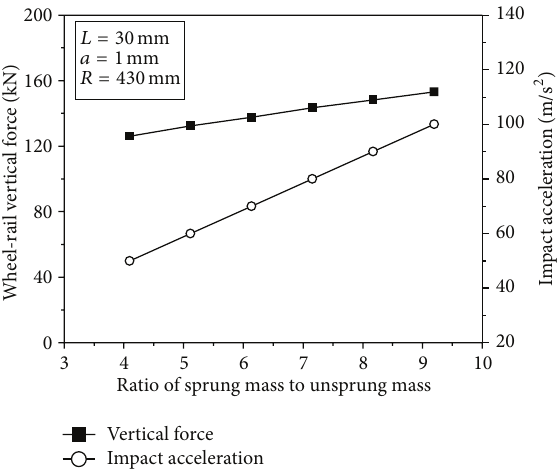
Figure 13: Wheel-rail vertical force and impact acceleration versus ratio of sprung mass to unsprung